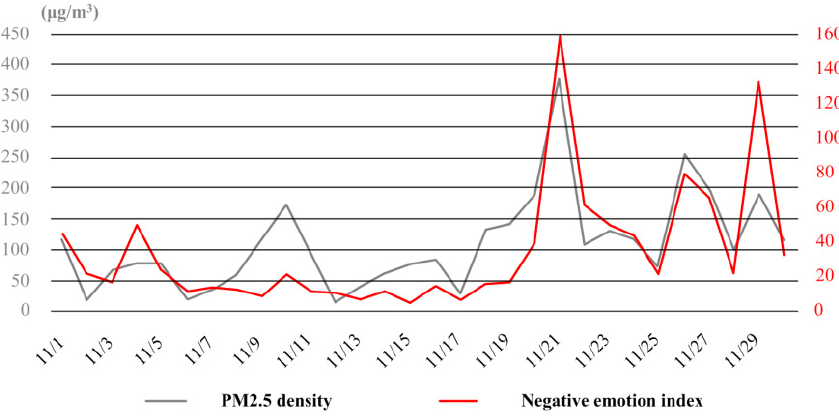
Figure 8. The variation curves of PM2.5 density and negative emotion index in November.